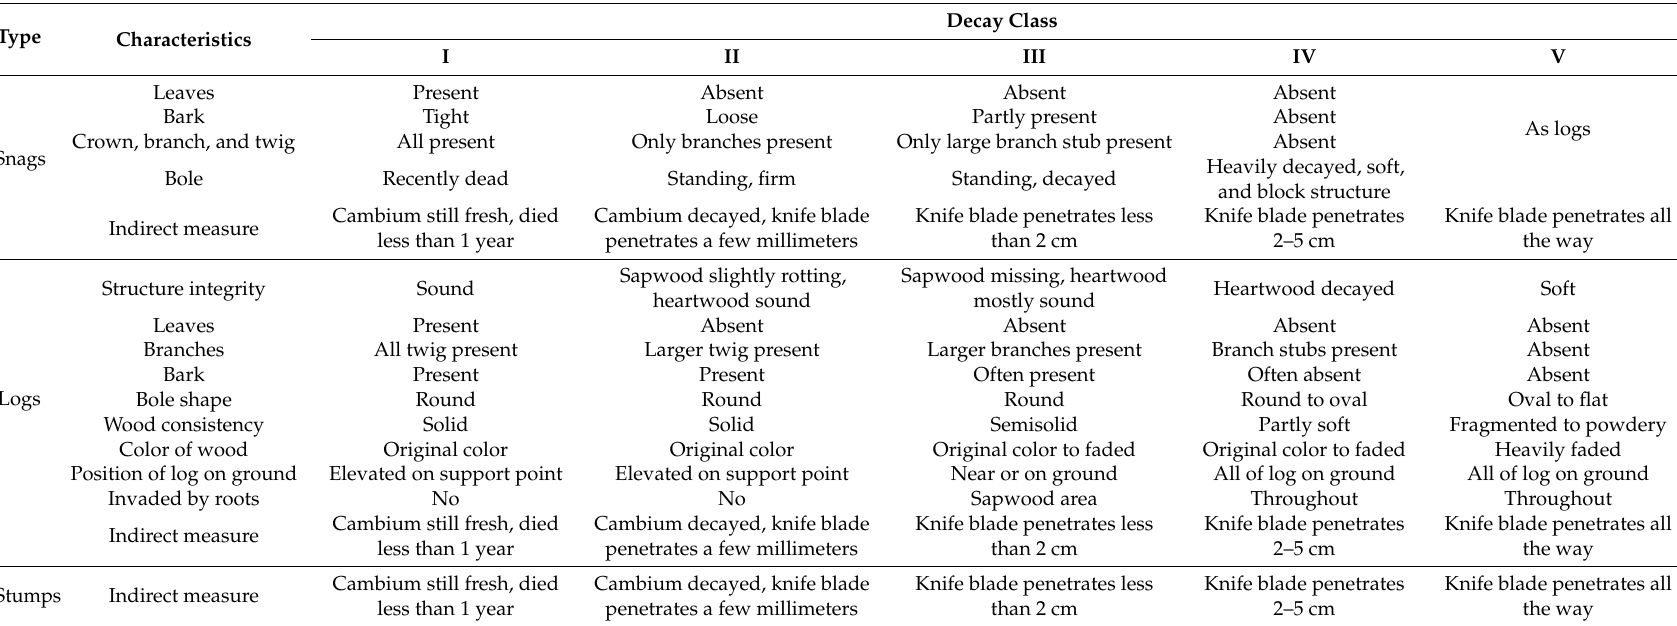
Table 2. Coarse woody debris (CWD) characteristics of different decay classes in a forest